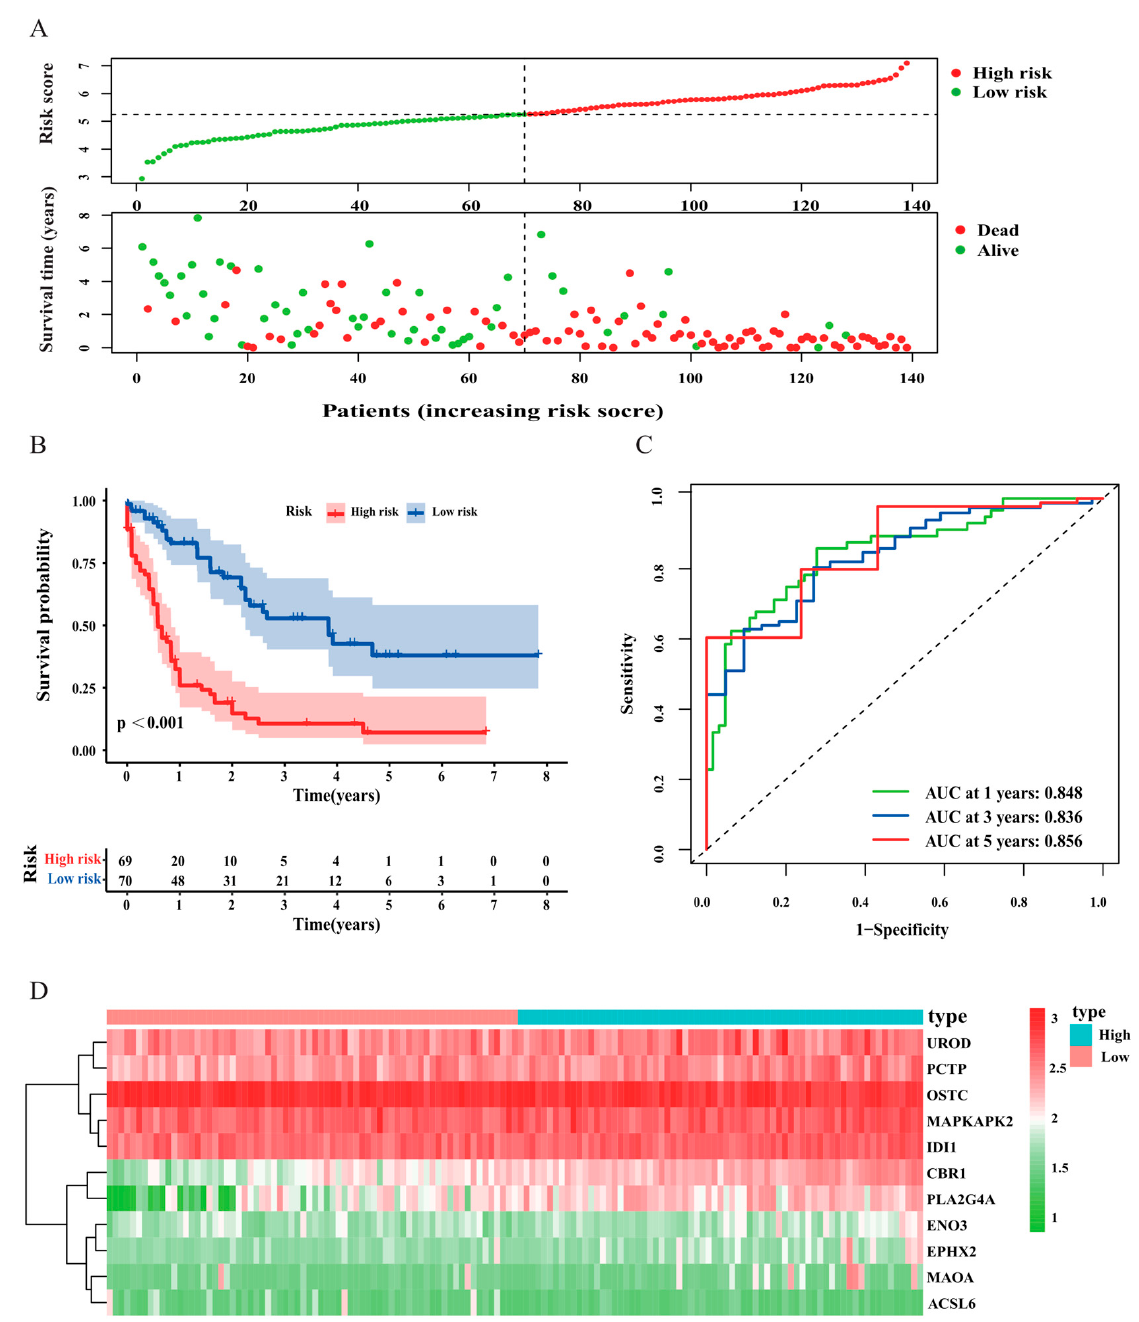
Figure 4. The correlation between risk score and survival status in the training cohort. ( A ) Distribution of the risk scores ( top ) and survival status of each patient ( bottom ). ( B ) Kaplan–Meier curve of the signature. ( C ) ROC curves for predicting survival at 1 year, 3 years, and 5 years. ( D ) Heatmap depicting the differential expression of the 11 genes in AML patients.